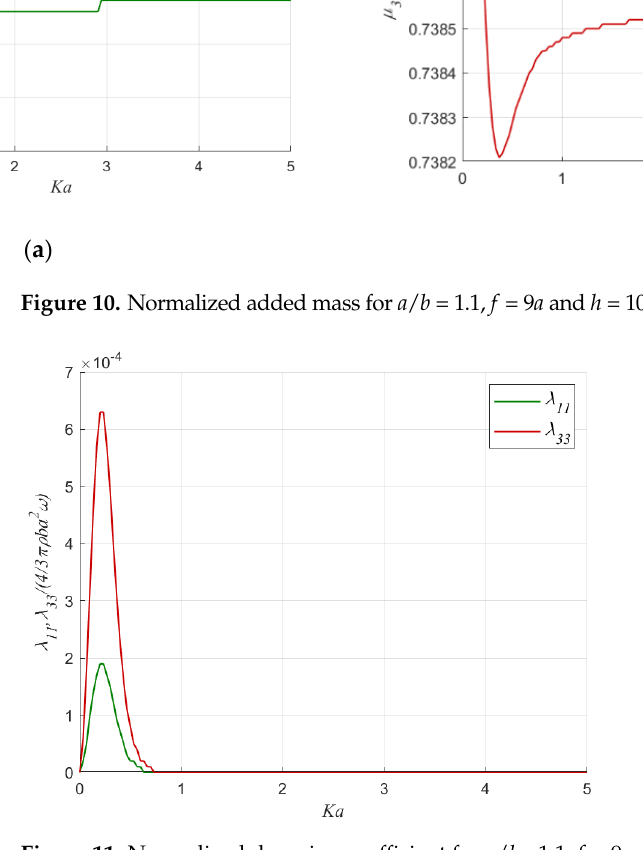
( b ) Figure 12. ( a ) An image of an axisymmetric disc; ( b ) A 2D schematic of the problem in the 𝑥 − 𝑧 plane. The whole formulation described in the aforementioned sections remains the same. Nevertheless, the limiting case 𝜉 (cid:2868) → 0 provides the following closed form expressions for the associate Legendre functions, i.e., [16]. 𝑃 (cid:3041)(cid:3040) (𝑖𝜉 (cid:2868) ) =